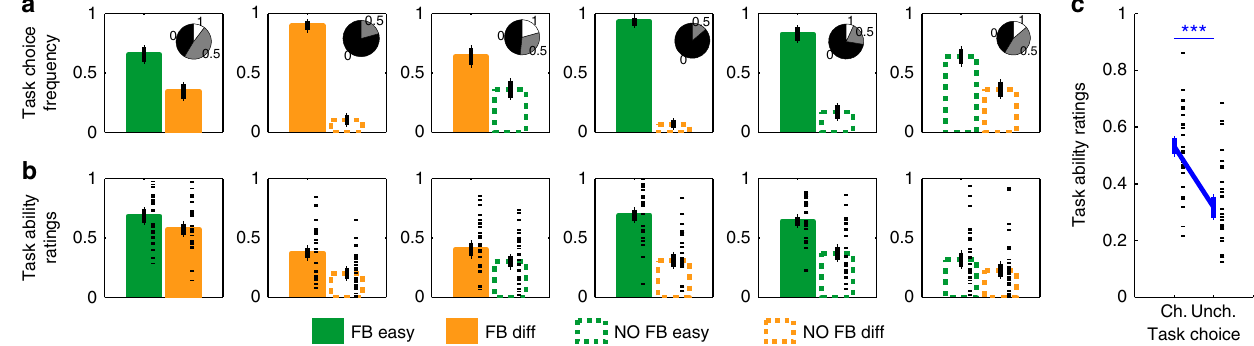
Fig. 3 Effects of task dif fi culty and feedback on global SPEs in Experiment 1 ( N = 29). a , b Task choice frequency ( a ) and task ability ratings ( b ) were visualized for the six task pairings. a Task choice frequencies could only take on the values 0, 0.5, or 1 due to the limited repetitions of pairing types per subject; pie charts display the fractions of subjects for whom these values were 0, 0.5 or 1 (for the right-hand bar of each plot). b Black dashes are individual data points. c Chosen tasks (Ch.) were rated more highly than unchosen tasks (Unch.), indicating consistency across our two measures of SPEs. *** p < 0.000001, paired t test. Error bars represent S.E.M. across